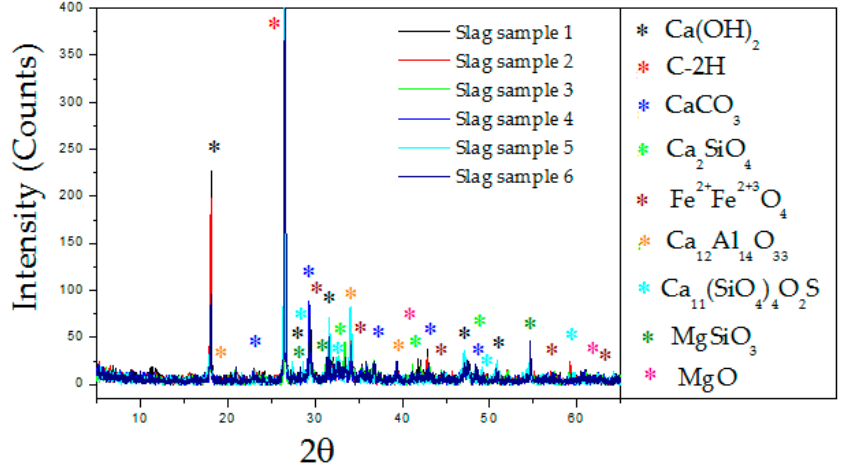
Figure 1. XRD diffractogram of the slag samples with signaling of the characteristic peaks of the minerals